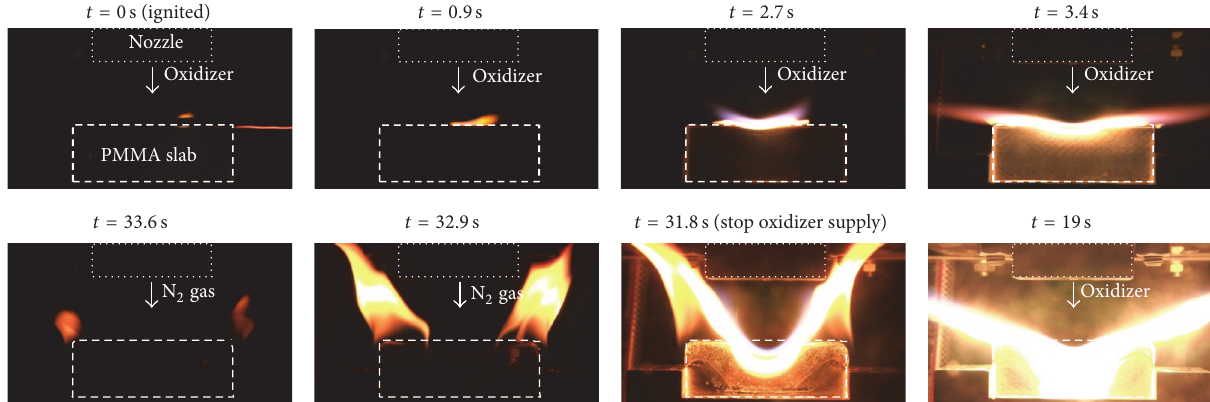
Figure 2: Time sequential images of PMMA combustion for 𝑉 = 5.6 m/s and H = 24